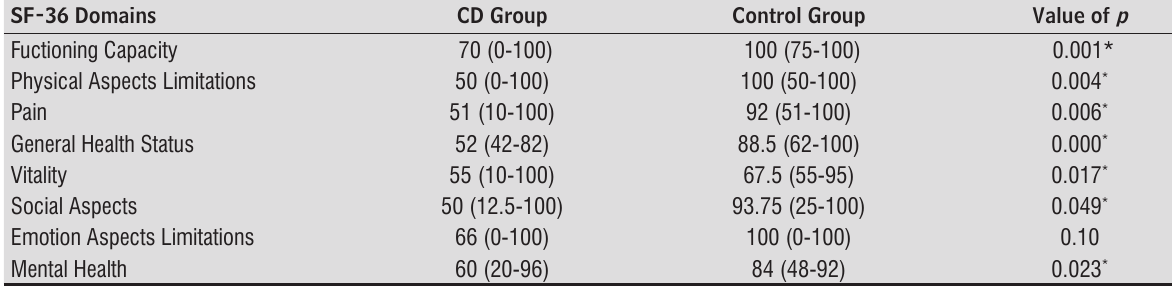
Table 2 - Characterization of health-related quality of life by